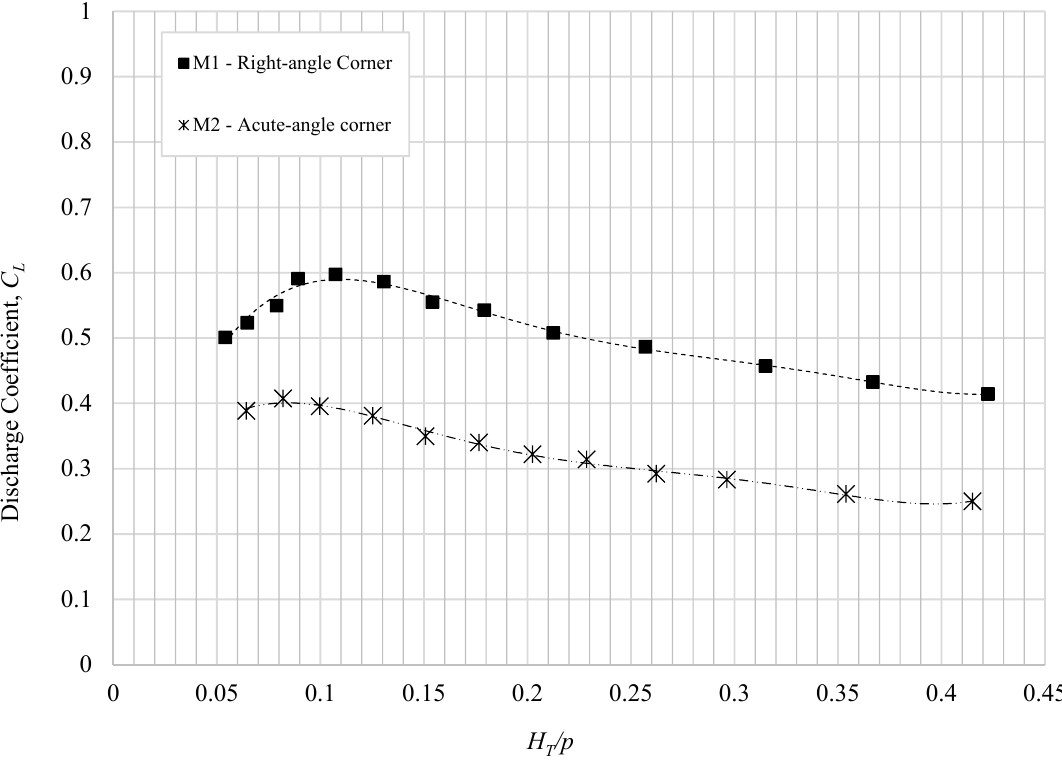
Figure 12. Variation of discharge coefficient ( C L ) versus H T / P for M1 and M2 models. Table 3. Percentage changes in the unit discharge due to the corner shapes. Parameters